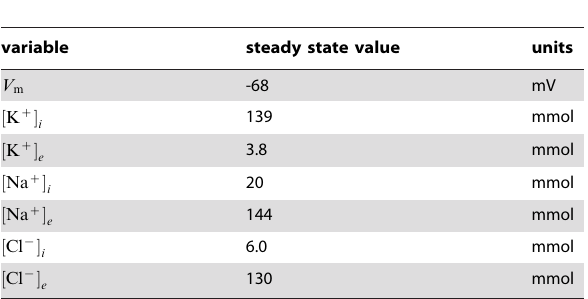
Table 2. Overview of the variables in the steady state.